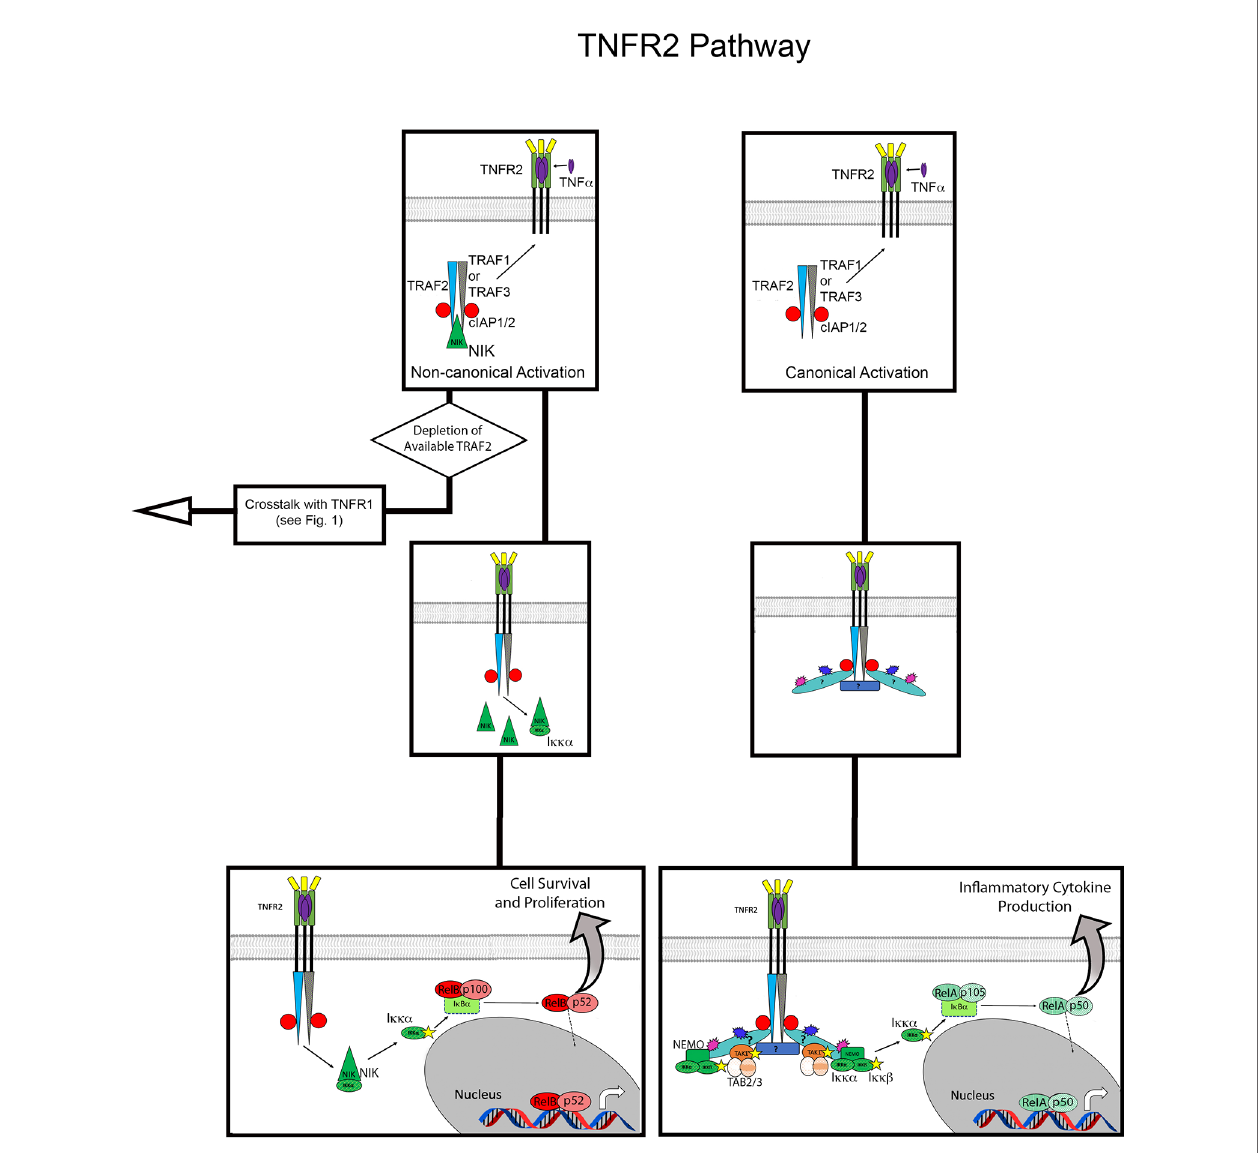
FIGURE 2 | Overview of TNFR2 activation pathway. Flow diagram for TNFR2 activation contrasting the non-canonical versus canonical pathways. The top panels show recruitment of TRAF proteins, cIAP1/2 and NIK to TNFR2 upon binding ligand (mTNF a ). On the left, this assembly leads to non-canonical NF k B activation via accumulation of NIK. On the right, the pathway of canonical NF k B activation is shown, the details of which are unknown but presumably result from K63 and M1 polyubiquitin chains mediating the recruitment of TAK1 and NEMO. Stars indicate phosphorylation, blue bursts represent ubiquitination, purple burst represent M1 ubiquitination. Question mark in canonical pathways indicate the target of ubiquitination is